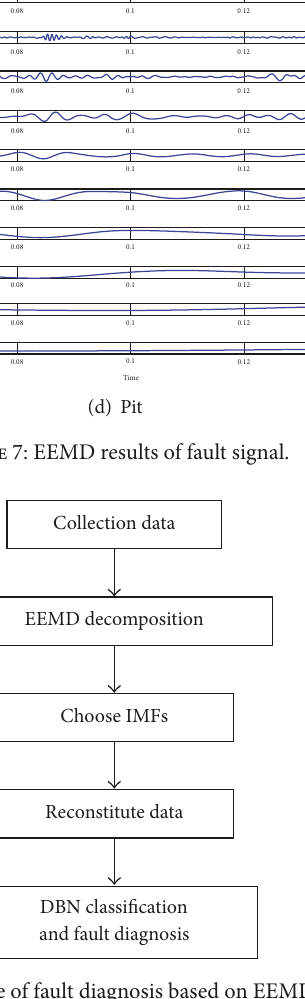
Figure 8: Procedure of fault diagnosis based on EEMD and DBN.